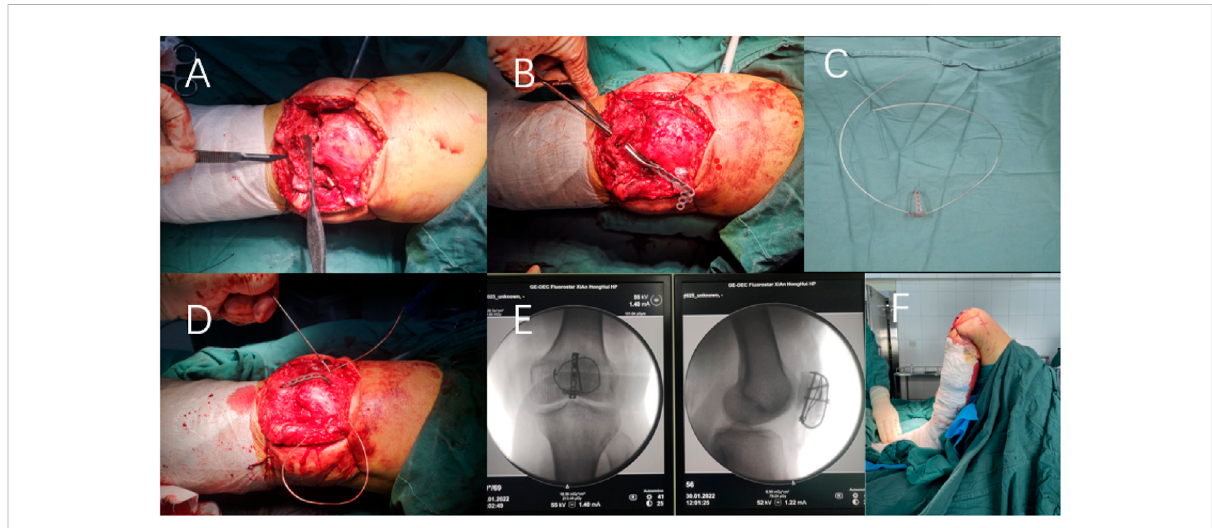
FIGURE 3 Intraoperative situation of ALP in the treatment of inferior pole patellar fracture. (A) Incision of a small opening at the junction of the patellar ligament and inferior pole with a scalpel. (B) One end of the long arm of the pre- fl exed plate passes through the small opening of the patellar ligament. (C) Plasticized bone plate penetrated steel wire. (D) Ring wire assisted by lumbar puncture after fracture reduction. (E) Intraoperative fl uoroscopy. (F) Immediate joint passive fl exion and extension